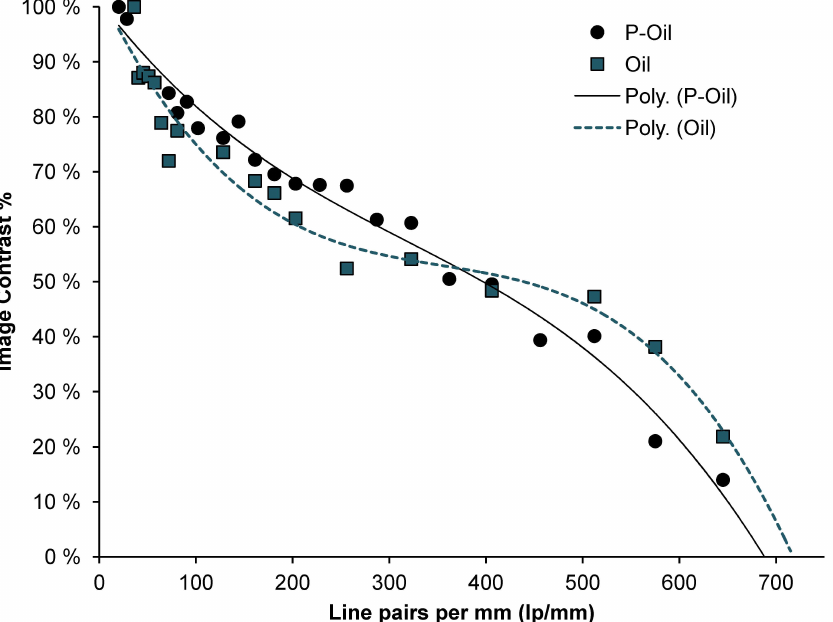
Figure 7. Image contrast (%) versus line pairs per mm for the combined system. The sample was a resolution plate that was imaged in air. The spacer thickness was 5 µm and NA (theoretical) is